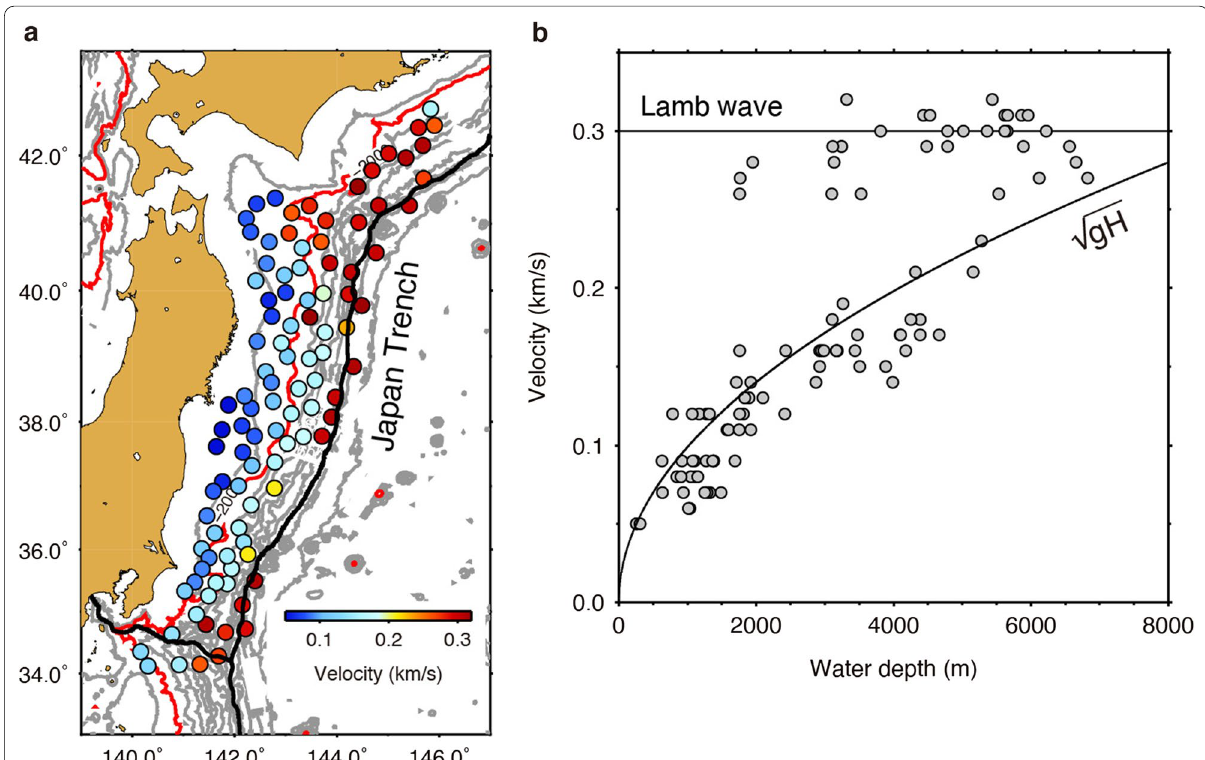
Fig. 2 Propagation velocities of meteotsunamis and free waves. a Propagation velocities at the centers of the triads. b Plot for propagation velocity of the first arrival versus water depth H . Curved line indicates the tsunami wave velocity √ gH , where g is the gravitational acceleration. The horizontal line represents a typical Lamb wave velocity of 0.3